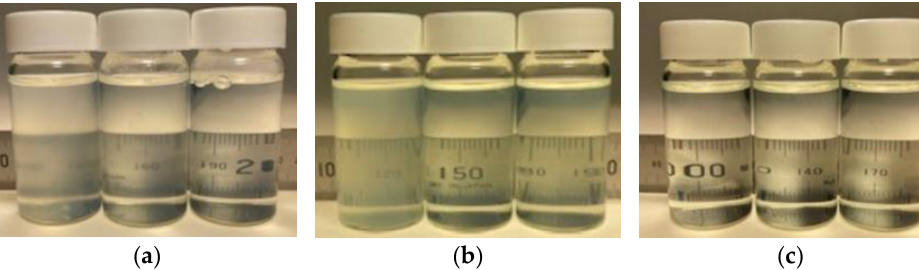
solution in DEG, 15% BL01 solution in DEG and 20% BL-01 solution in DEG; ( b ) from left to right,